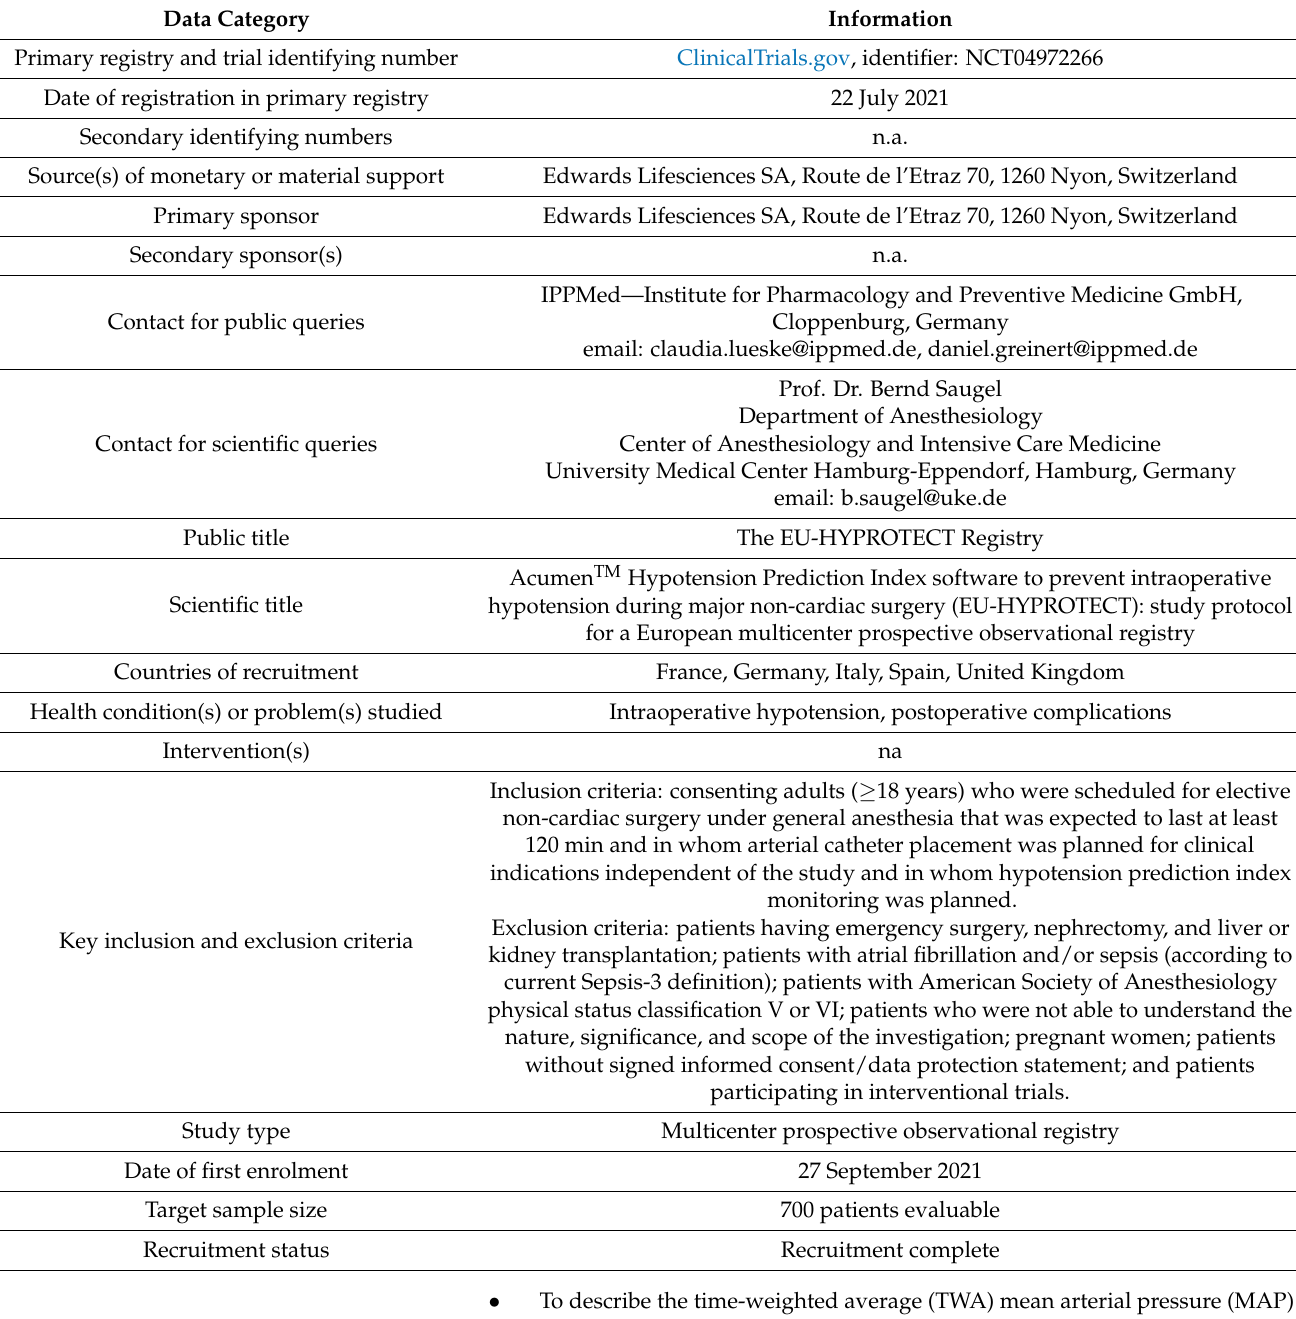
Table 1. Trial registration